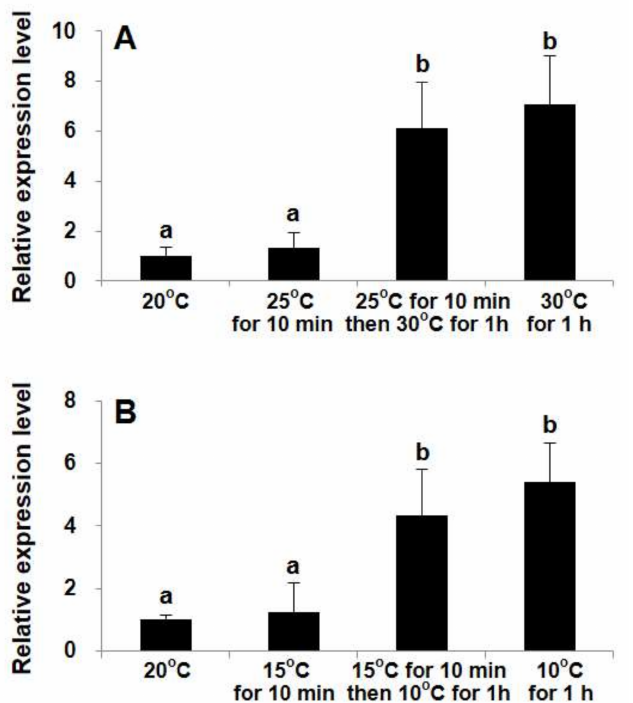
Figure 2. The transcription levels of StHsp90 in cells exposed to one-step or stepwise temperature shock (+10 ◦ C ( A ) and − 10 ◦ C ( B )). One-step shock: put the cells directly in a temperature variation of 10 ◦ C for 60 min. Stepwise shock: first, put the cells in a temperature variation of 5 ◦ C for 10 min and then subject them to a further 5 ◦ C change for 60 min. The 20 ◦ C maintained cultures are used as the control. The relative expression values are shown as the mean fold changes compared to the control, with the error bars depicting the standard deviations ( n = 3). Same letter above the bars denotes no significant difference ( p > 0.05) in abundance.